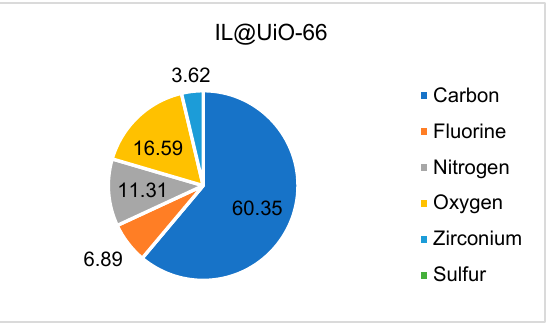
Figure 5. The atomic percentage of IL@UiO-66 calculated from EDX.